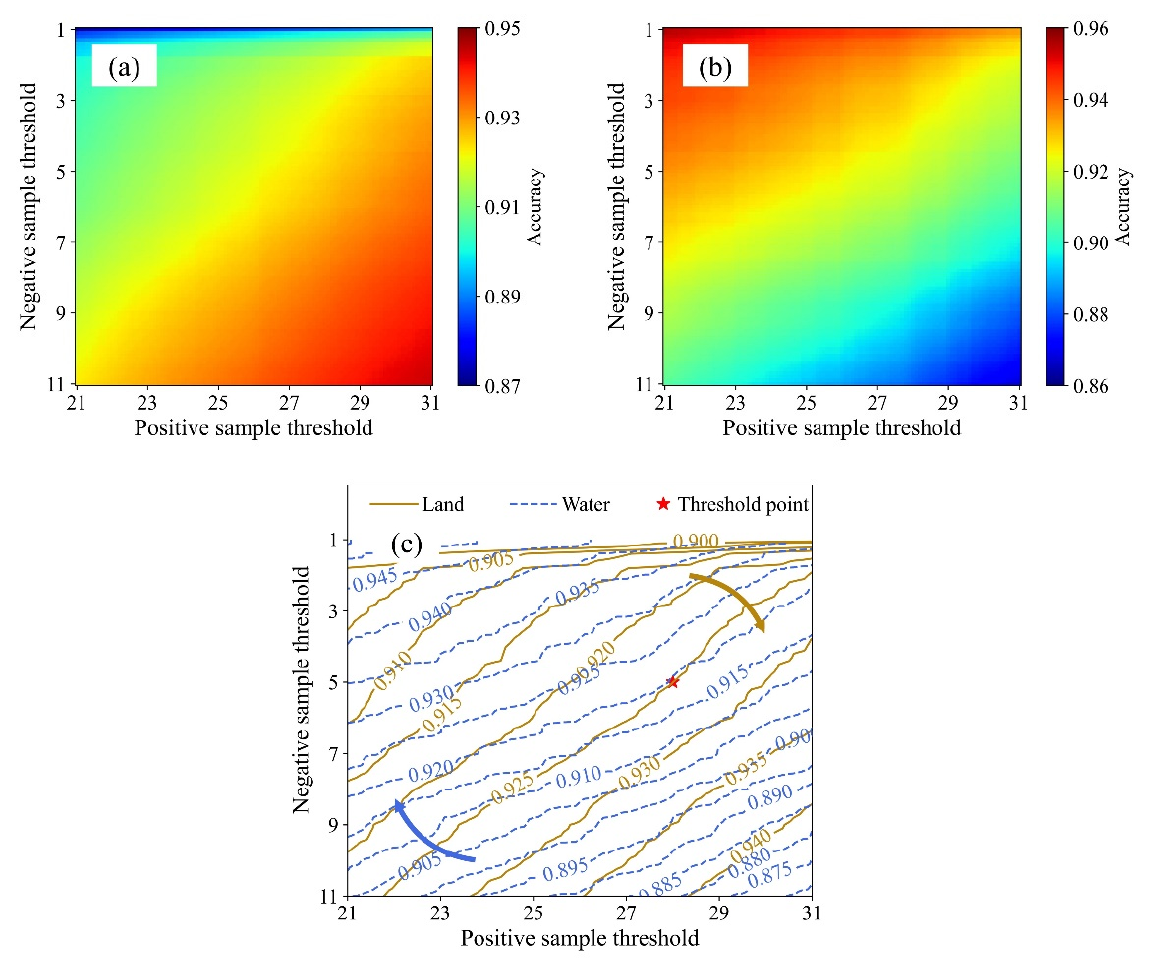
Figure 7. Land ( a ) and water ( b ) detection accuracies with various threshold combinations. ( c ) The contour map with water and land detection accuracies and the determined threshold combination is marked with a red star. The colored arrows indicate the corresponding increased directions of both accuracies.